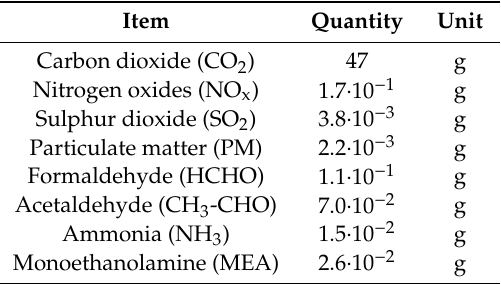
Table A2. Foreground inventory of use-phase emissions per kWh of electricity generated by the NGCC + CCS system.